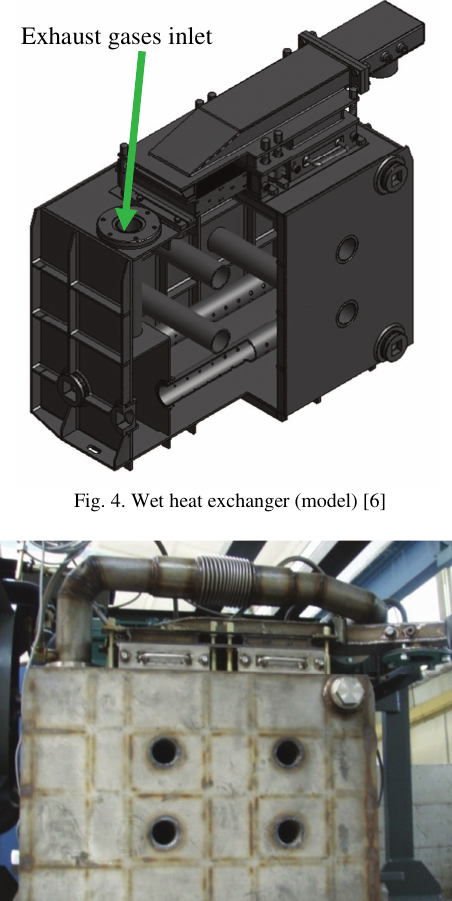
Fig. 5. Wet heat exchanger (real view) [6]